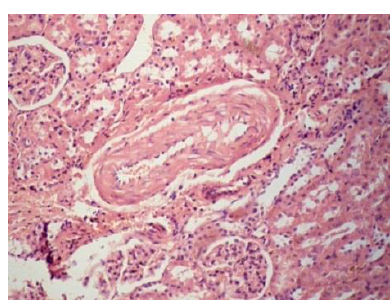
Fig. 2. Cortical substance of rat kidney. SHR rat control group. Hypertrophic walls of vessels. Staining with he- matoxylin and eosin. Eye. 10×. Lens. 10×.